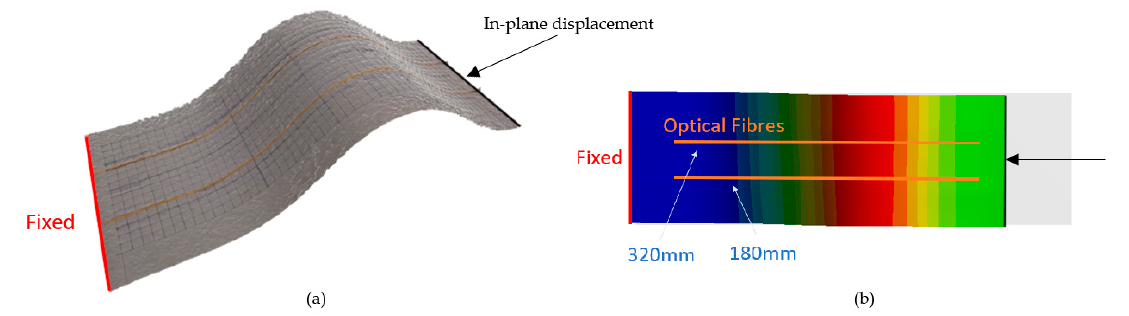
Figure 5. ( a ) 3D DEM of the in-plane deformed membrane specimen; and ( b ) labelled constraints, in-plane displacement load and location of the optical fibre recordings along horizontal lines on the grid.